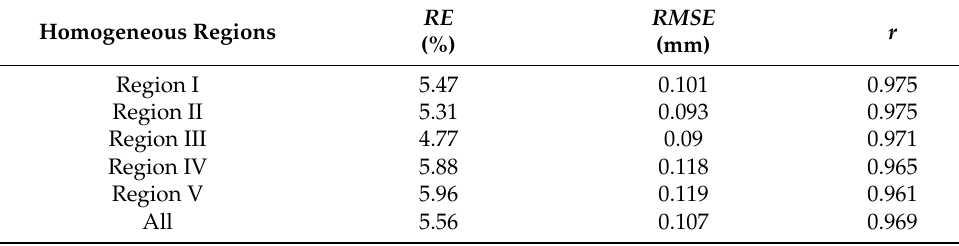
Table 5. Comparisons between estimation and